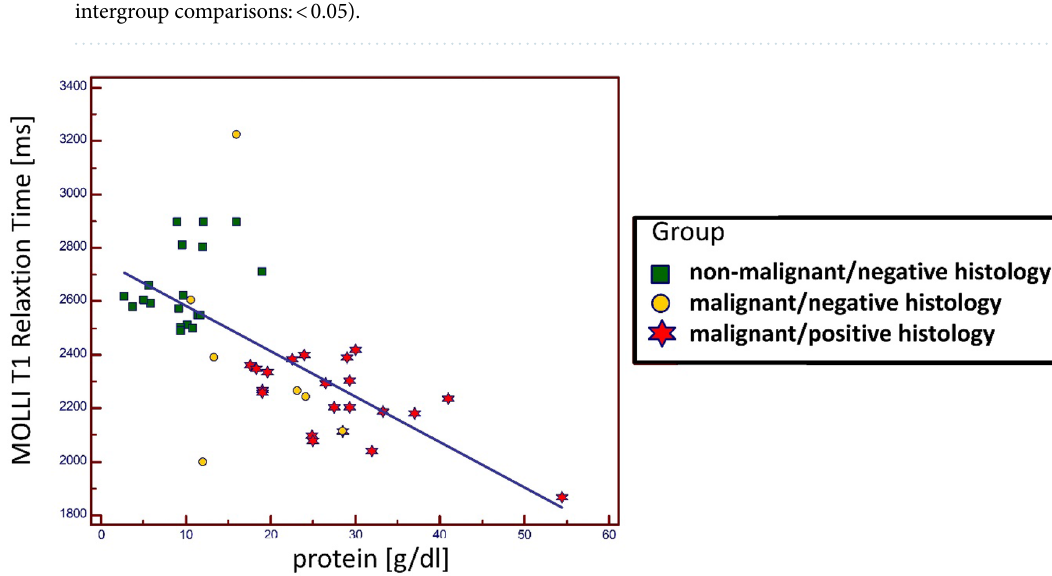
Figure 4. Regression analysis for ex-vivo MOLLI T1 Relaxation time measurements: MOLLI T1-Relaxation time (dependent variable) and protein content (independent variable). Linear regression established that for ex-vivo measurements, protein content was associated with MOLLI T1-relaxation time measurements (r = − 0.69) Effusions were defined as non-malignant/negative histology (green squares) if patients had no known malignancy and histology/cytology was negative; as malignant/negative histology (red star) if patients had known malignancy but histology/cytology was negative; as malignant/positive histology (yellow circle) if patients had known malignancy and histology/cytology was